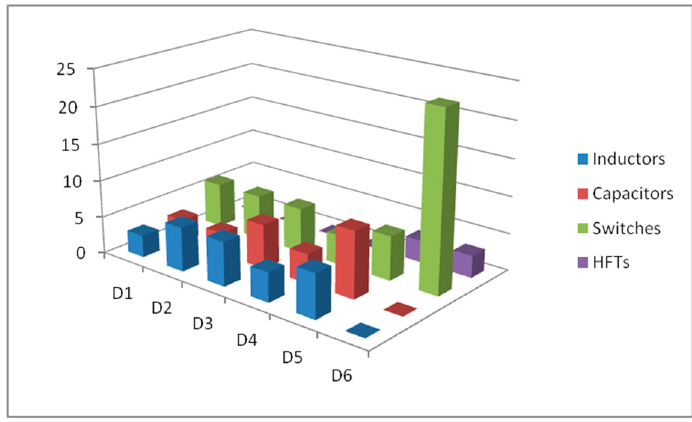
Figure 10. Components count utilized in three-phase differential microinverters topologies presented in previous studies (see [81–86]).